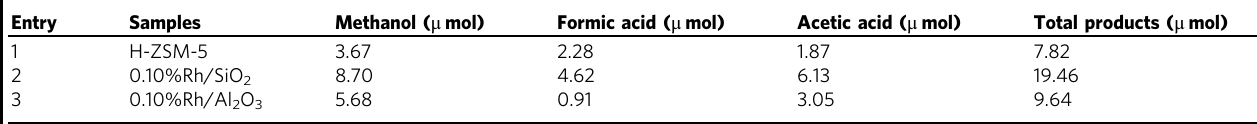
Table 2 Catalytic performances of 28 mg catalysts of 0.10 wt%Rh supported on different supports in a mixture of 10 bar CH 4 , 10 bar CO, and 8 bar O 2 at 150 °C for 3 h with 10 mL H 2 O in a high-pressure